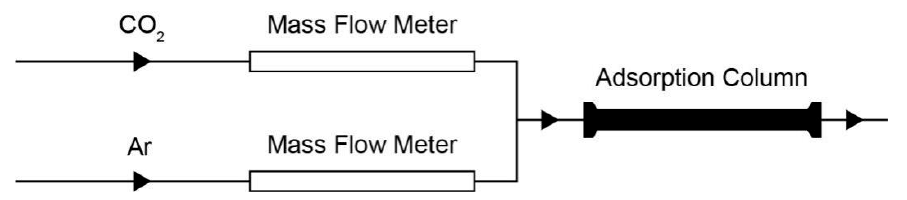
Figure 3. Single stage fixed-bed flow system .